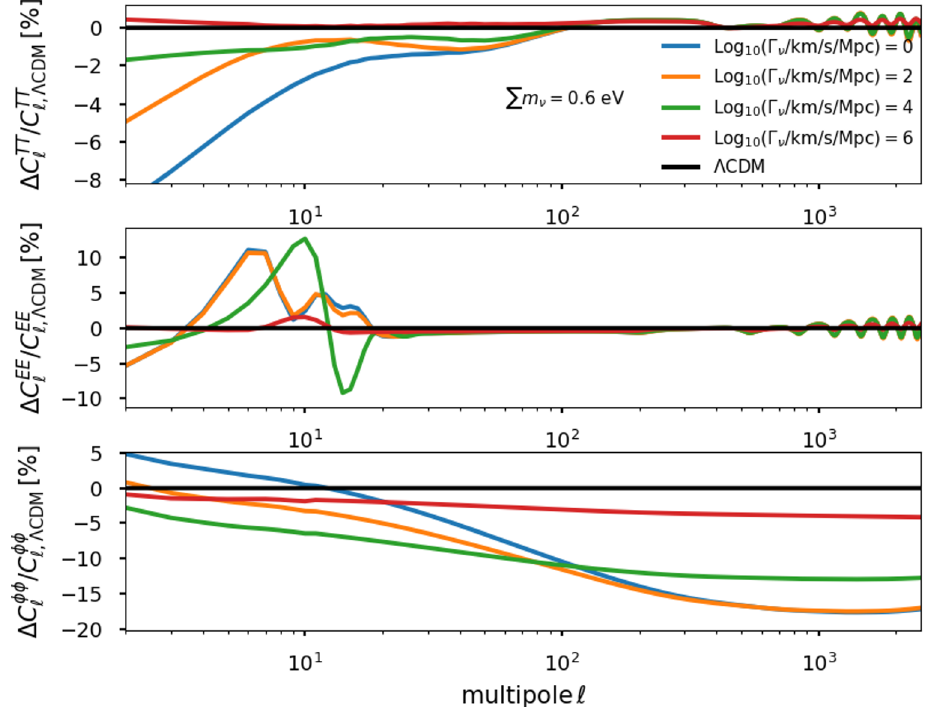
Figure 2 . Residuals in the CMB lensed TT (upper), EE (middle) and lensing (lower) spectrum for a fixed value of the neutrino mass and several decay widths. The residuals are taken with respect to the Λ CDM best-fit parameters from Planck 2018. The Λ CDM parameters are kept fixed in all